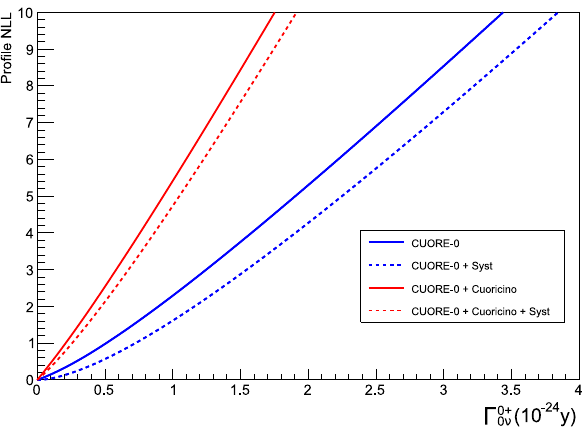
Fig. 4 Negative log likelihood (NLL) from CUORE-0 and the combi- nation with CUORICINO for 0 νββ